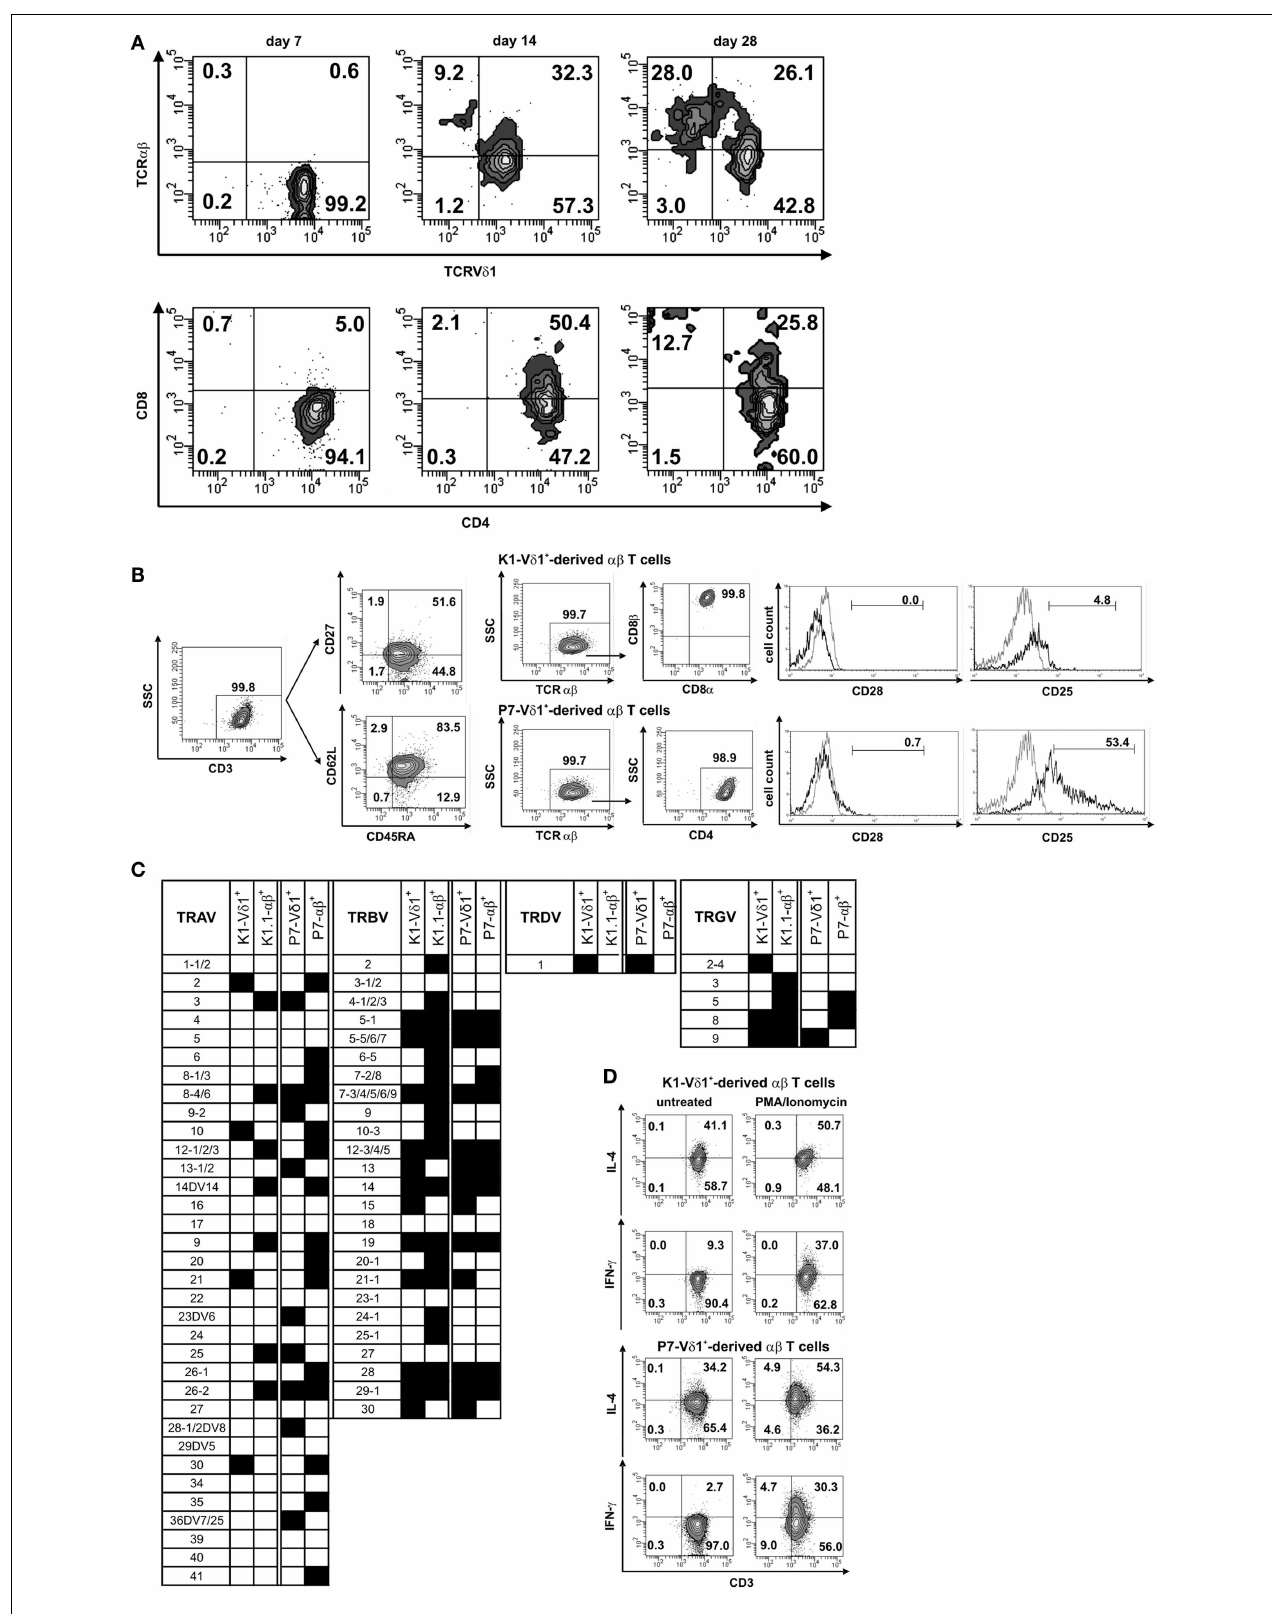
FIGURE 5 | CD4 + V δ 1 + T-cell clones change theirTCR intoTCR- αβ and can change their co-receptor